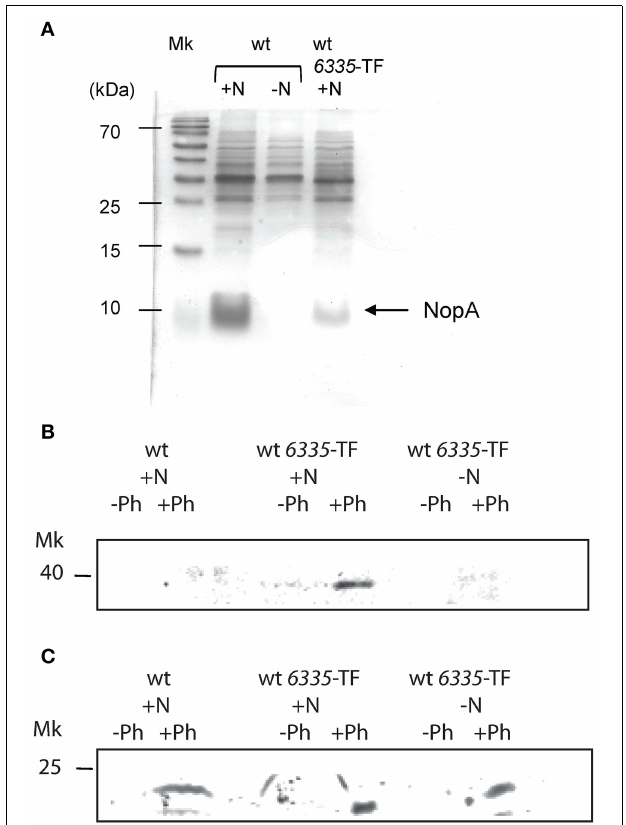
FIGURE 6 | Detection of the 3xFLAG RhcC2 fused protein in total membrane fraction. (A) Silver staining of supernatant proteins of MAFF303099 (wt) and MAFF303099 with sequence encoding the 3xFLAG RhcC2 fused protein integrated into the bacterial chromosome (wt 6335 -TF). Total membranes of wt and wt 6335 -TF strains were separated by 12.5% SDS-PAGE and immune-bloted and probed with anti-FLAG antibody (from mouse) (B) , and with anti-Omp19 antibody (from rabbit) (C) . For detection fluorescent anti-mouse and anti-rabbit antibodies were used. All bacteria contain plasmid pMP2112. ± N: with or without induction with naringenin, ± Ph: with or without phenol